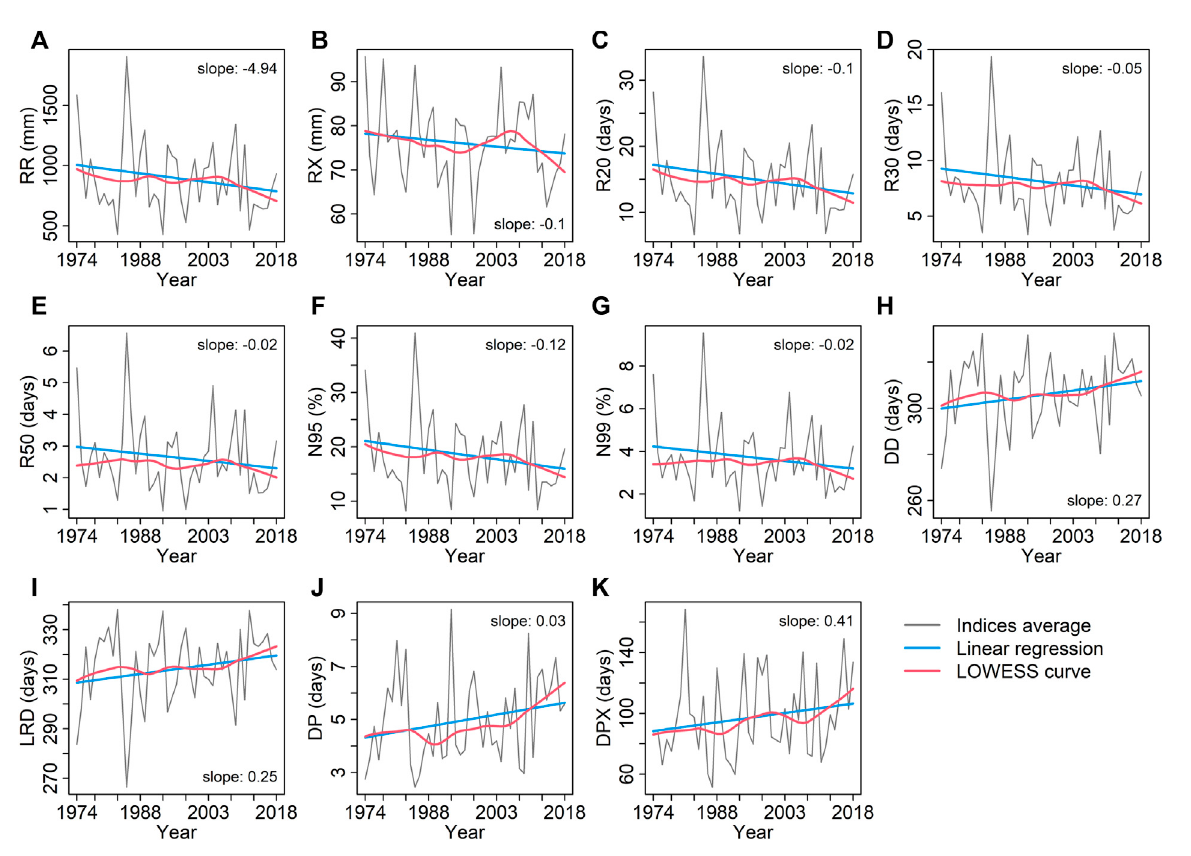
FIGURE 4 LOWESS curve (red line) and linear regression (blue line) related to (A) RR, (B) RX, (C) R20, (D) R30, (E) R50, (F) N95, (G) N99, (H) DD, (I) LRD, (J) DP and (K) DPX of target stations during the annual period from 1974 to 2018. The number refers to a slope of linear regression. The * symbol indicates the slope was signi fi cant at the 5%